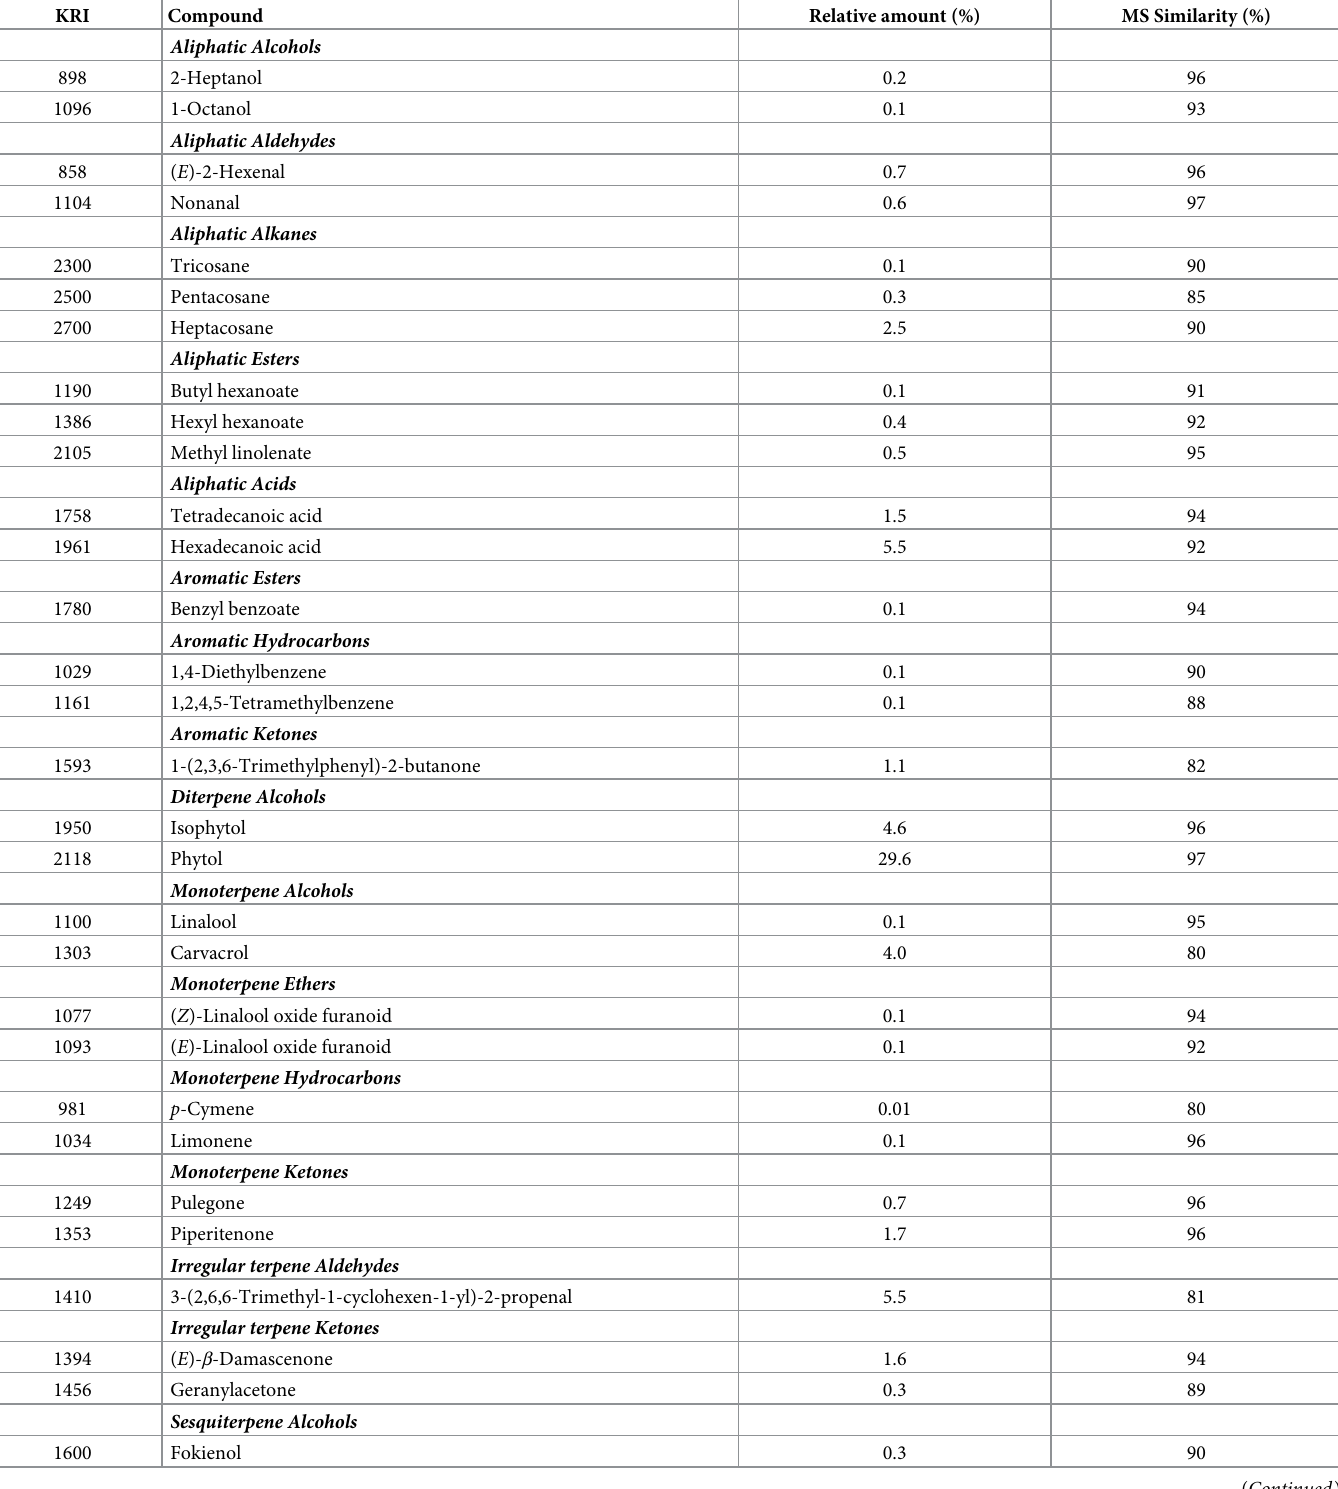
Table 1. Essential oil composition of C . juttae . Compounds belonging to the same chemical class and functional group are arranged according to Kovats Retention Indi- ces (KRI) of the ZB-5